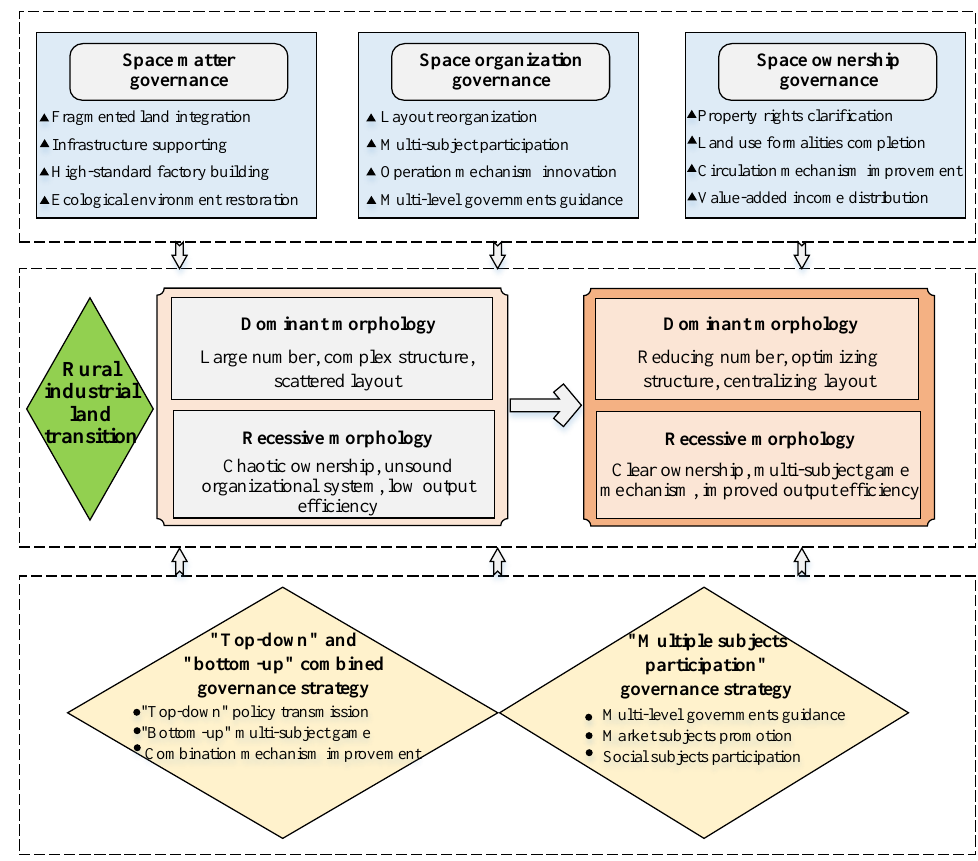
Figure 8. The transition mechanism of Hengding Industrial Park under spatial governance.